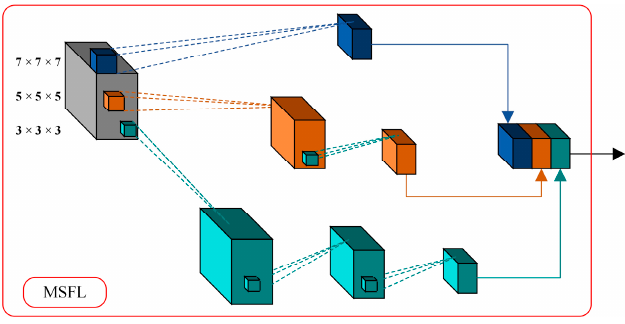
Figure 3. Multiscale feature extraction module.